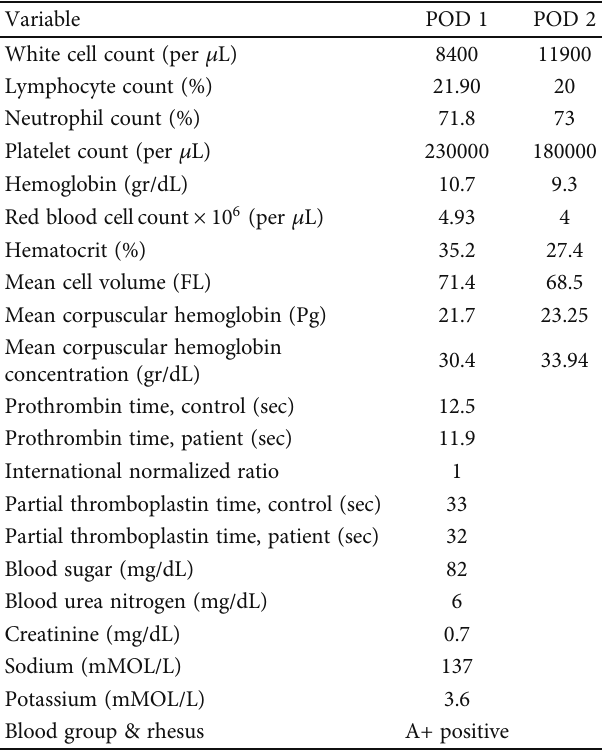
Figure 2: Lateral face view of the patient at 7 hours after surgery. Table 1: Laboratory fi ndings of the